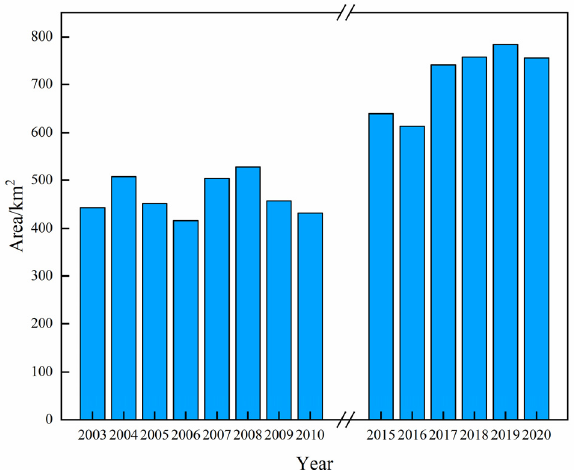
Figure 8. Area occupied by buildings in the Binhai New Area extracted with the GEE from 2003 to 2010 and 2015 to